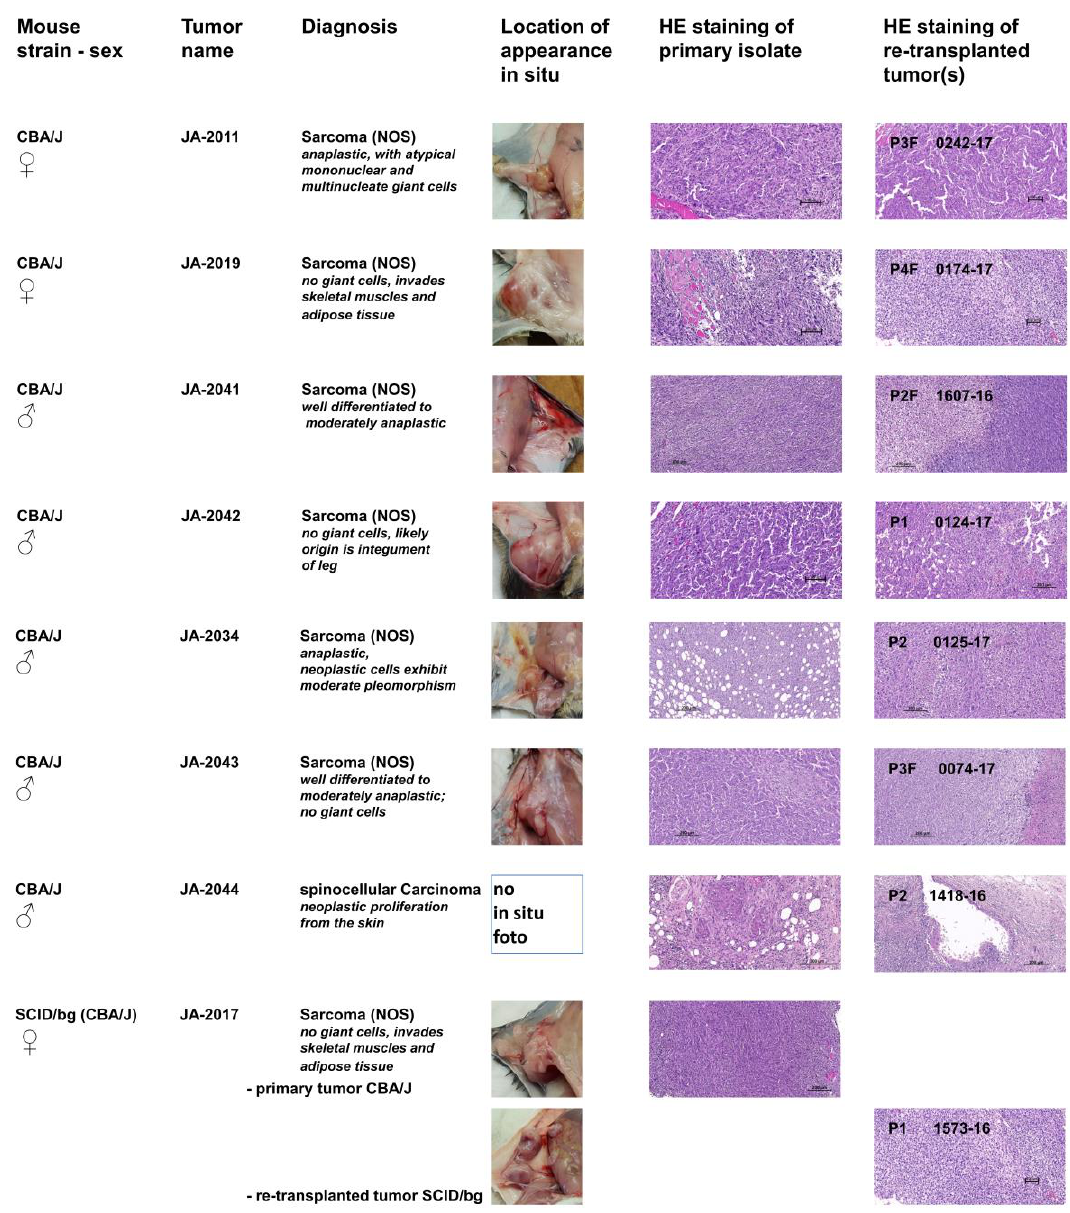
Figure 2. Histopathological characterization of established cMDI tumors. In situ location of primary tumor or suspicious tissue during necropsy, as well as hematoxylin and eosin (HE)-staining of resected primary and re-transplanted tumors using directly isolated (of passages P1–P4) or frozen tumor pieces (of passages P2F–P4F) are documented for eight cMDI models. NOS—sarcomas could not be otherwise specified by HE-staining. JA-2017 originated from female CBA/J but only grew in immune-deficient SCID/bg.